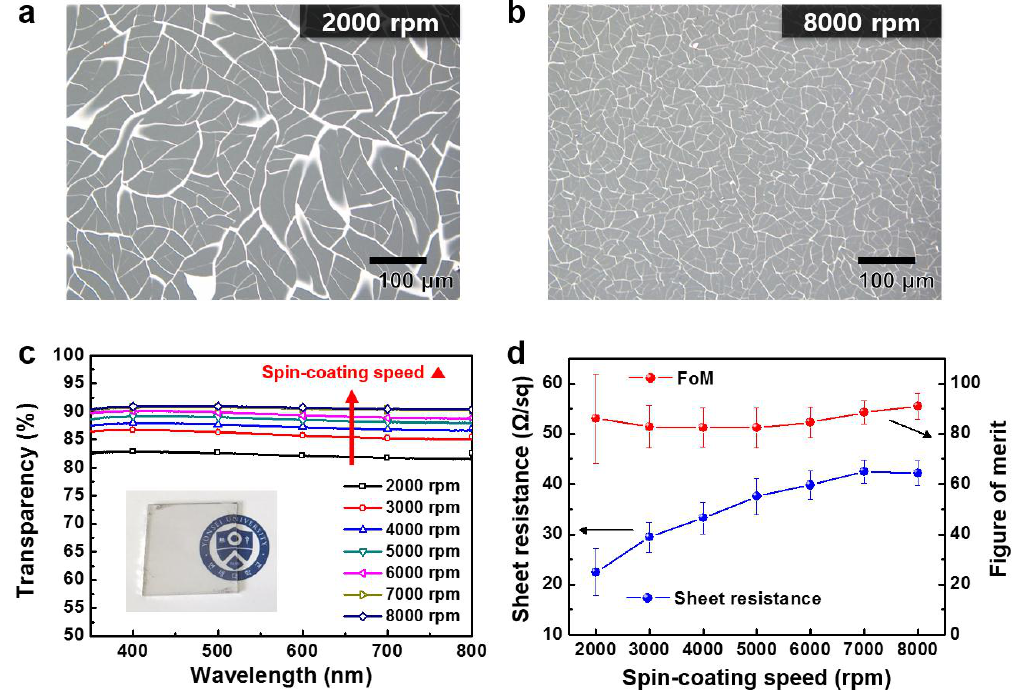
Figure 2. Optical microscopy (OM) images of the fabricated MMS using different spin-coating speeds; ( a ) 2000 and ( b ) 8000 rpm; ( c ) optical transparency in the visible region; and ( d ) sheet resistance and figure of merit (FoM) of the fabricated MMS using different spin-coating speeds. Inset in (b) shows a photograph of the MMS on a glass substrate (2.5 cm × 2.5 cm) fabricated with a spin-coating speed of 7000 rpm.